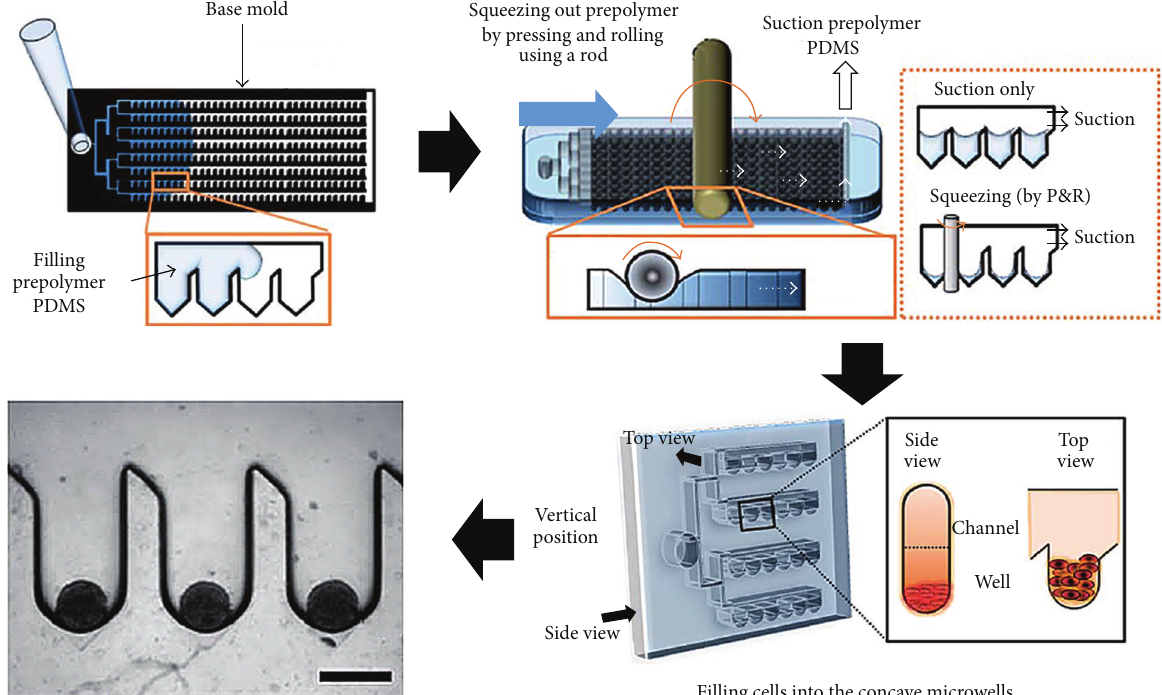
Figure 2: Schematic representation of concave microwell generation utilizing surface tension force. First, the pentagonal-shaped microwells were filled with prepolymer solution and exposed to squeezing/suction. Concave wells were created by a little residual polymer solution due to the surface tension. The ESCs were then injected into microchannel (and microwells) for trapping a uniformal quantity of ESCs to produce the same-sized